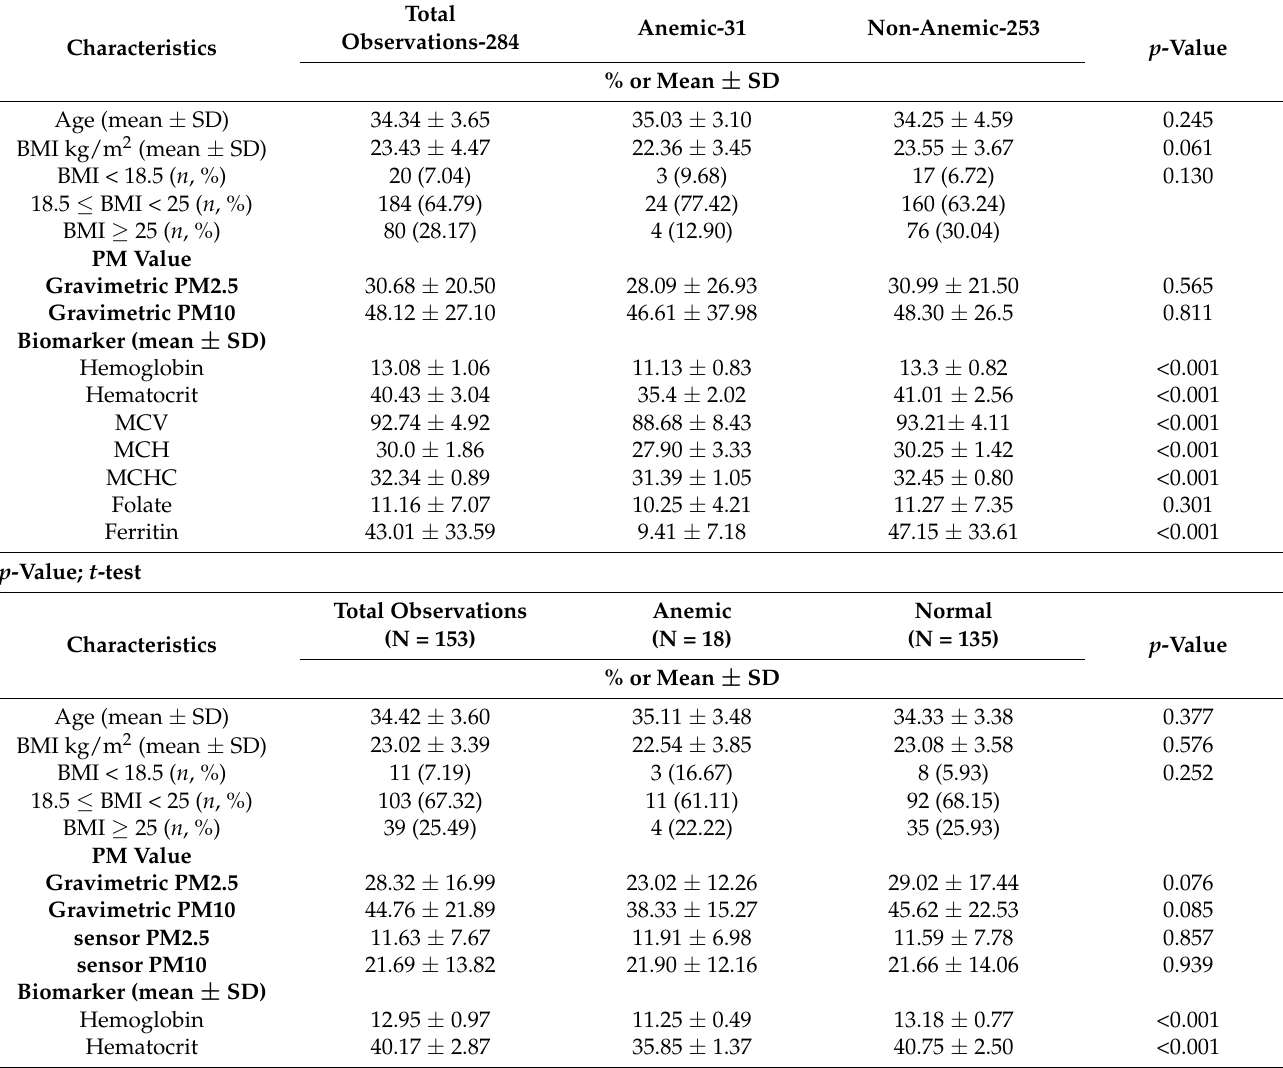
Table 1. Characteristics of study